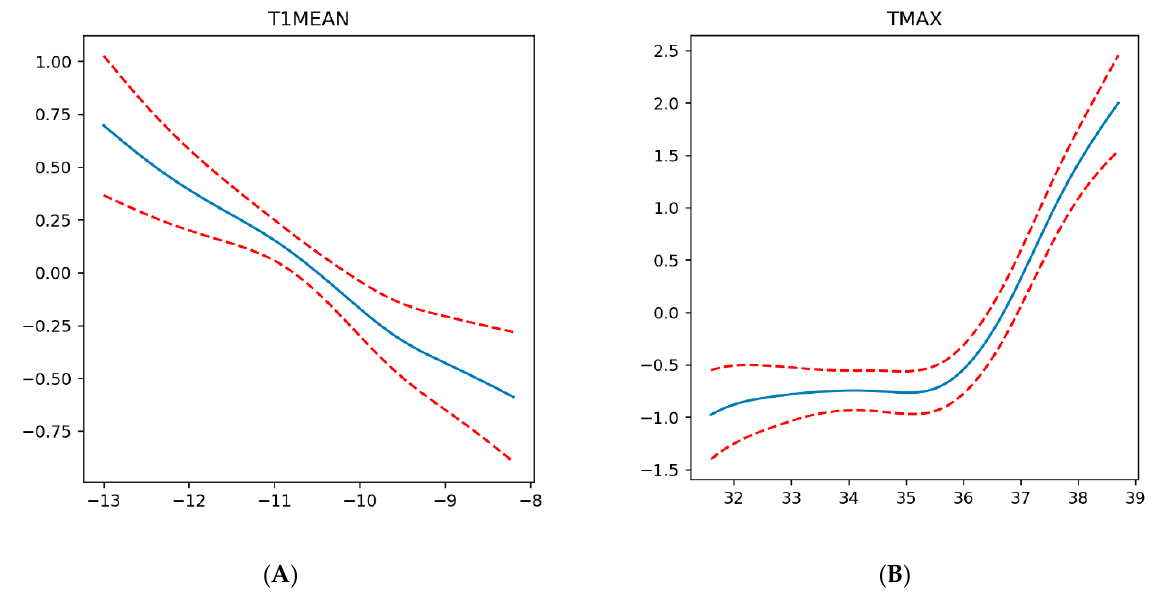
Figure 14. Dependence of rill erosion density on temperature factors (°C)—mean annual temperature in January ( A ) and mean annual maximum temperature in the warm season ( B ).